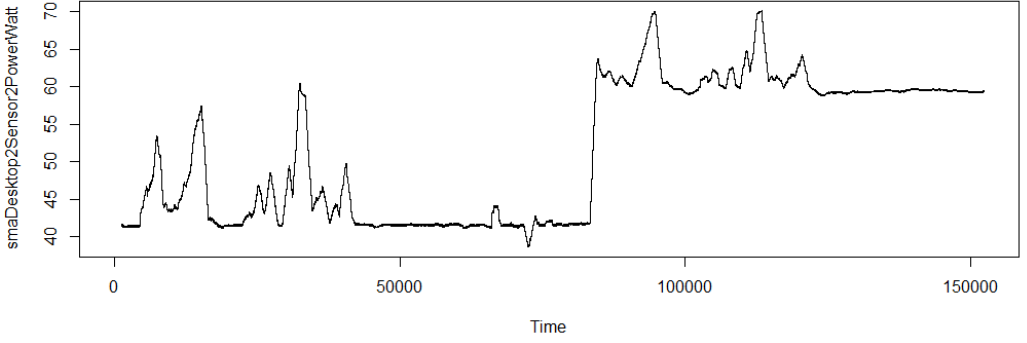
Figure 4. Smooth moving average with n = 1200 (20 min).